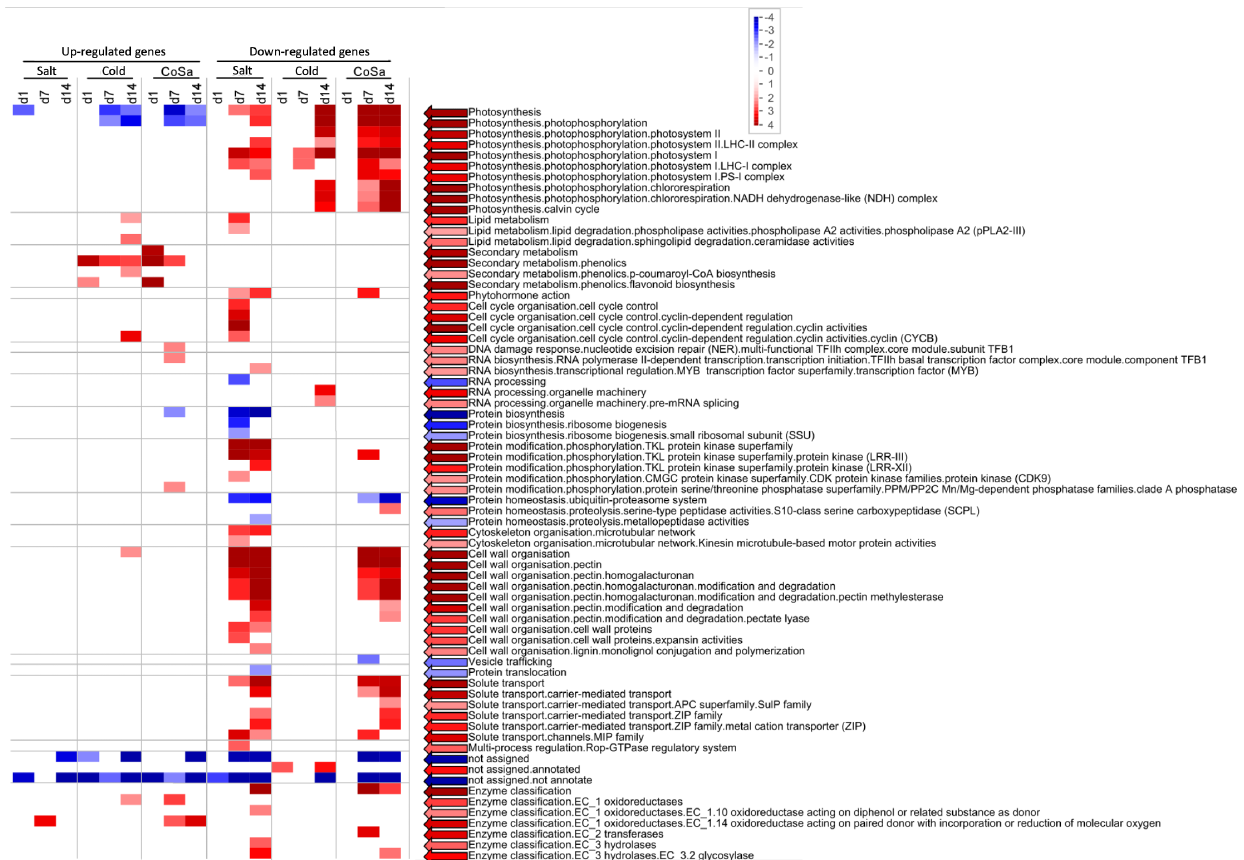
Figure 3. Overrepresentation analysis (ORA) performed for up- or down-regulated DEG of Mazurka. Plants were grown under different abiotic stress conditions (Salt, chilling temperatures: Cold, and combinations thereof: CoSa) on rockwool. The leaf after first branching was harvested and a transcriptome analysis was performed comparing the different stress conditions with the control sample. The over- or underrepresentation of indicated Mercator [71] bins were calculated separately for up- (left column) and down-regulated genes (right column) using a Fisher test [65] in combination with a multiple testing correction as performed by Benjamini and Hochberg [72]. Overrepresented bins are shown in red and underrepresented bins in blue, respectively.